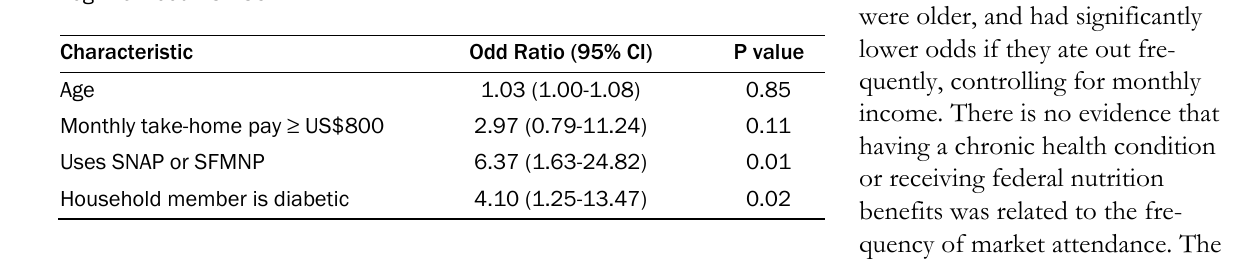
Table 3. Odds Ratios for Logistic Regression Model Predicting Average Spending of ≥